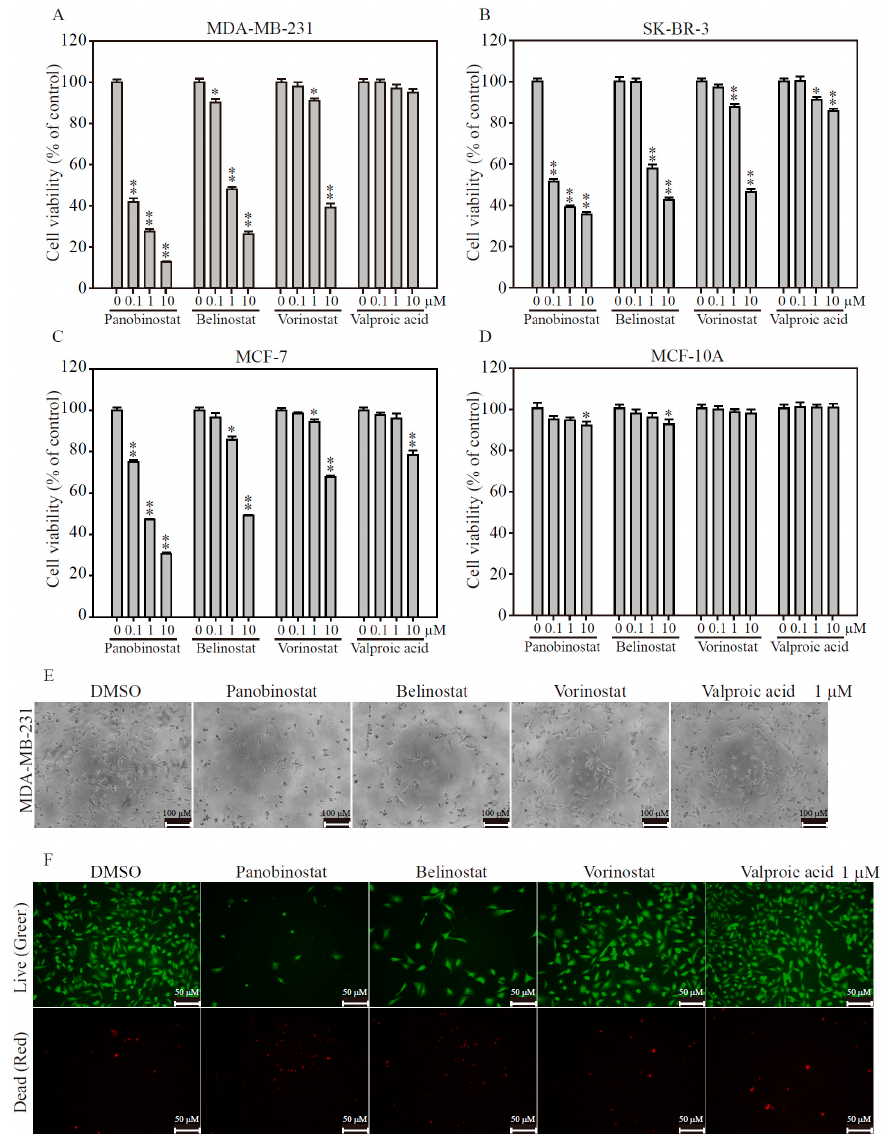
Figure 2. HDACi inhibits breast cancer cell viability and enhances cell apoptosis. Dose-dependent manner of 0.1, 1 and 10 μ M Panobinostat, Belinostat, Vorinostat and Valproic acid inhibits ( A ) MDA-MB-231; ( B ) SK-BR-3; ( C ) MCF-7 breast cancer cells and ( D ) normal breast epithelia cells viabilities for 48 h by MTT assay determination; ( E ) The cell morphology change of 1 μ M HDACi treatment for 48 h on MDA-MB-231 cells. Scale bars: 100 μ M; ( F ) Fluorescence images of 1 μ M HDACi exposed MDA-MB-231 cells for 48 h and determined by LIVE/DEAD viability/cytotoxicity assay. The cells were co-stained with 1 μ M calcein-AM/10 μ M PI and excited with light of 488 nm (green emission) to show viable cells. The same image of the cells was also excited with light of 532 nm, (red emission) to show the dead cells. Scale bar: 50 μ M. Data are presented as the mean and standard error. Data were analyzed with Student’s t -test; all p -values were two-sided. p -values less than 0.05 are indicated with an asterisk, less than 0.01 is presented with two asterisks.